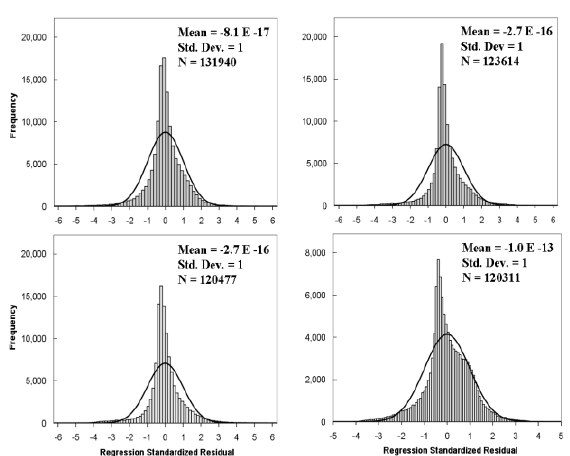
Figure 3. Scatterplot of GOSAT CAI and SPOT VGT NDVI for each pixels in November 2009 (a), January 2010 (b), April 2010 (c) and July 2010 (d).